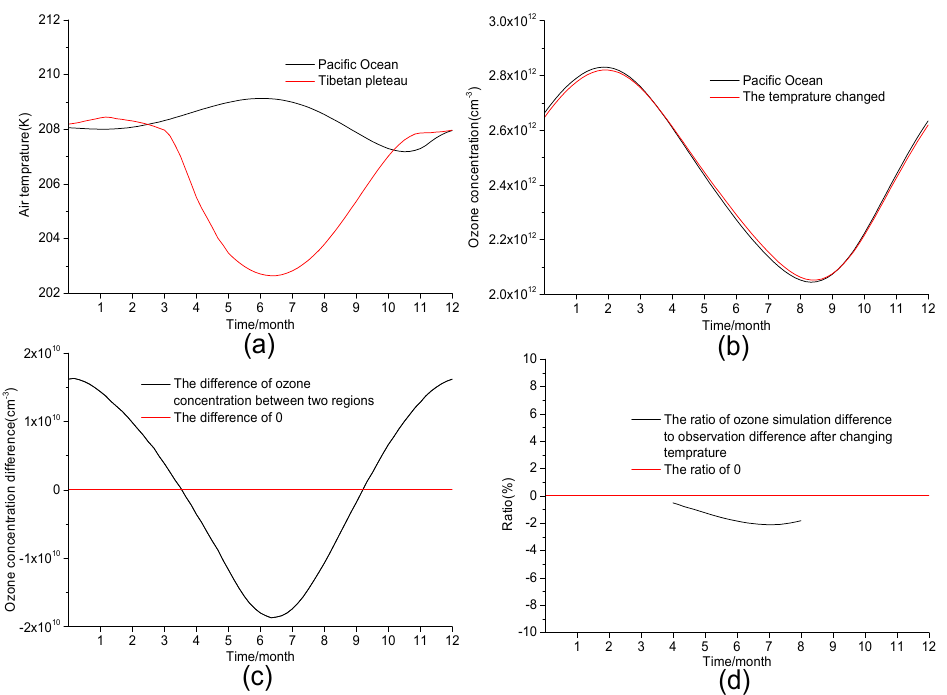
Figure 5. The results of air temperature changes ( a ) time-dependent variations in air temperature in the two regions; ( b ) simulated comparison of the ozone number concentrations in the two regions; ( c ) difference in simulated ozone number concentration between the two regions; ( d ) ratio of the ozone simulation difference to the observed difference after changing temperature.